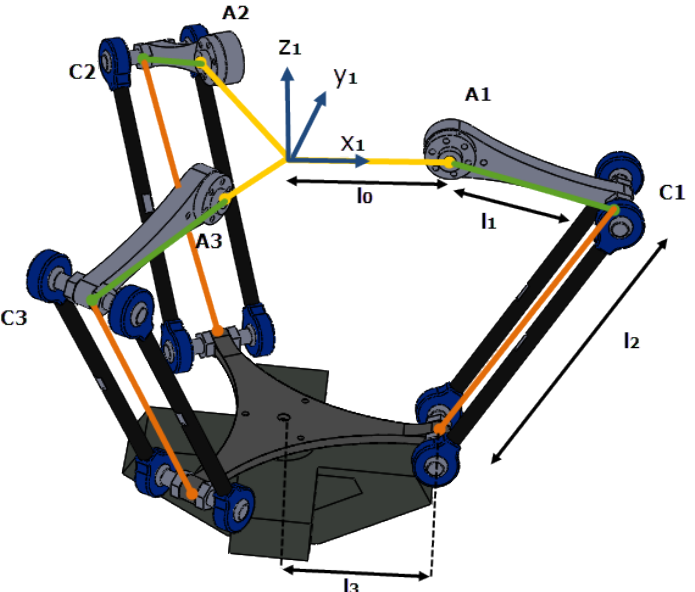
Figure 8. The kinematic chains of the delta part.